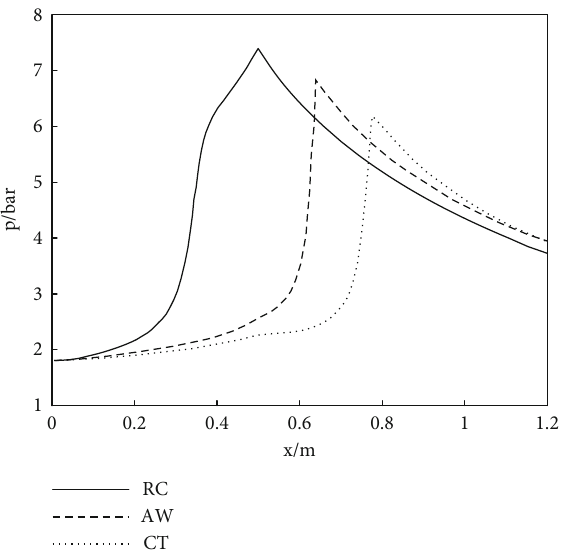
Figure 14: Pressure distributions along the combustor duct.